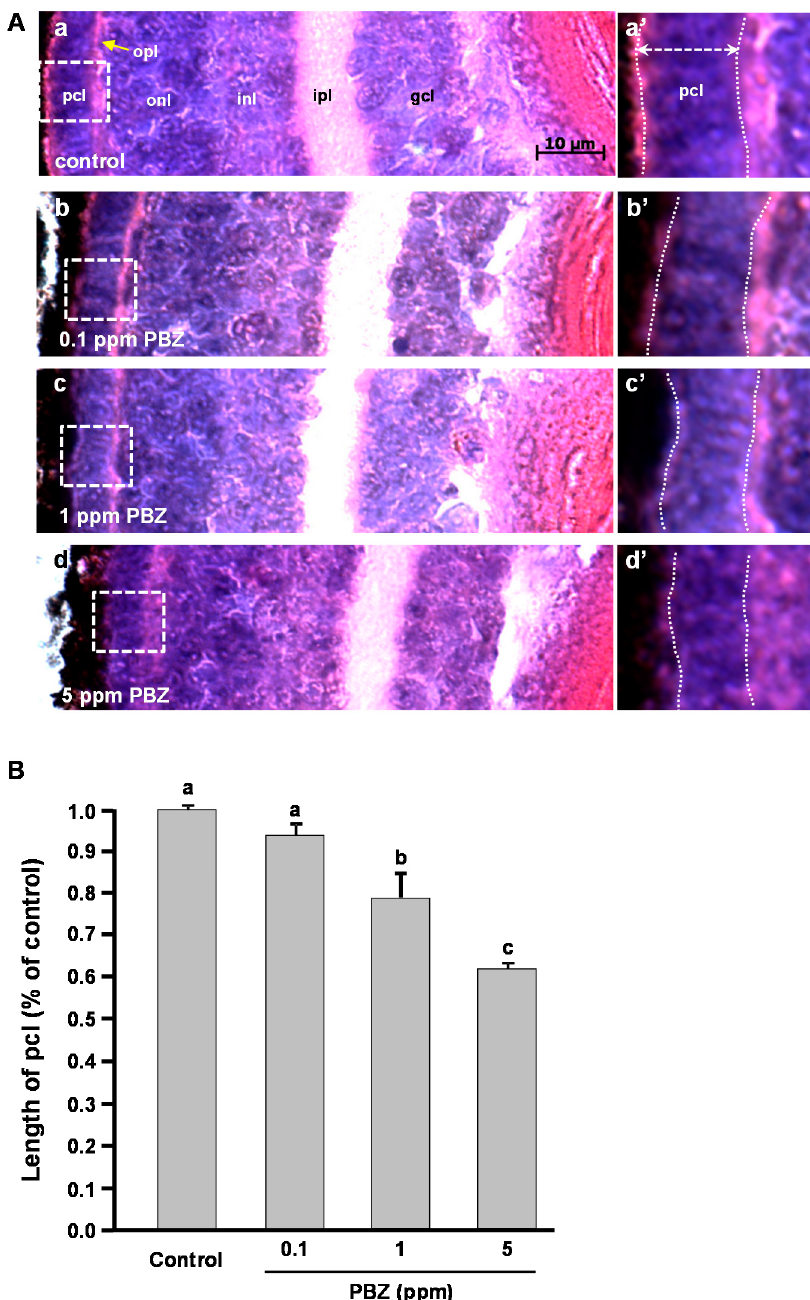
Figure 2. Paclobutrazol exposure significantly reduces the thickness of the photoreceptor layer in zebrafish embryos. ( A ) Hematoxylin and eosin (H&E) staining of eye sections from zebrafish treated with ( a ) 0.1% DMSO (control) or with ( b ) 0.1 ppm; ( c ) 1 ppm; or ( d ) 5 ppm. High-magnification images for the photoreceptor layer of the eyes are shown in a’ – d’ . Reference lines indicate the photoreceptor layer. gcl, ganglion cell layer; inl, inner nuclear layer; ipl, inner plexiform layer; onl, outer nuclear layer; opl, outer plexiform layer; pcl, photoreceptor cell layer; ( B ) Thicknesses of the photoreceptor cell layer were measured from control embryos and embryos treated with PBZ at 0.1, 1, or 5 ppm, with 20 embryos used per condition. Each group contains at least 10 embryos; Scale bar: 10 µ m. All values were normalized to the mean of the normal group. Bars sharing a letter are not significantly different from one another as assessed by one-way ANOVA, followed by Fisher’s least significant difference test ( p < 0.05). Error bars indicate standard error.